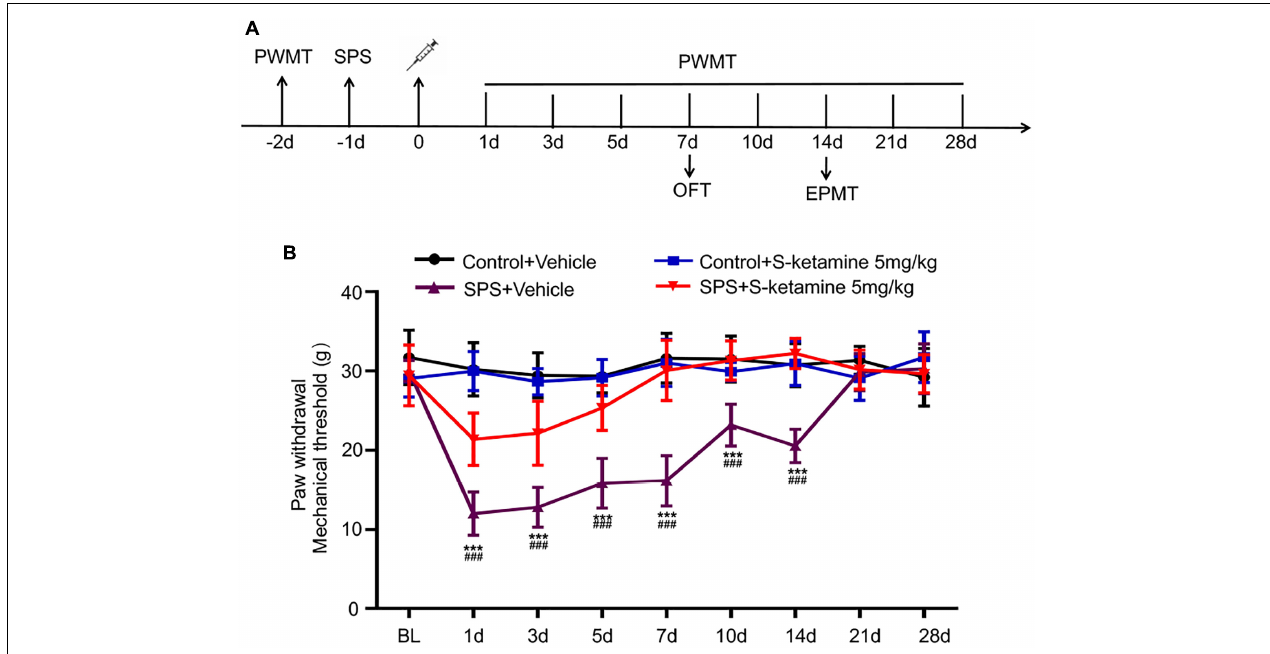
FIGURE 1 | S-ketamine alleviates chronic pain in the SPS-exposed rats. (A) Scheme diagram of behavioral tests and SPS injection in rats. Rats were randomly assigned into control + vehicle group, SPS + vehicle group, control + S-ketamine 5 mg/kg group and SPS + S-ketamine 5 mg/kg group. n = 8 per group. (B) Paw withdrawal mechanical threshold of rats in each group. *** P < 0.001, SPS + vehicle group vs. control + vehicle group; ### P < 0.001, SPS + S-ketamine 5 mg/kg group vs. SPS + vehicle